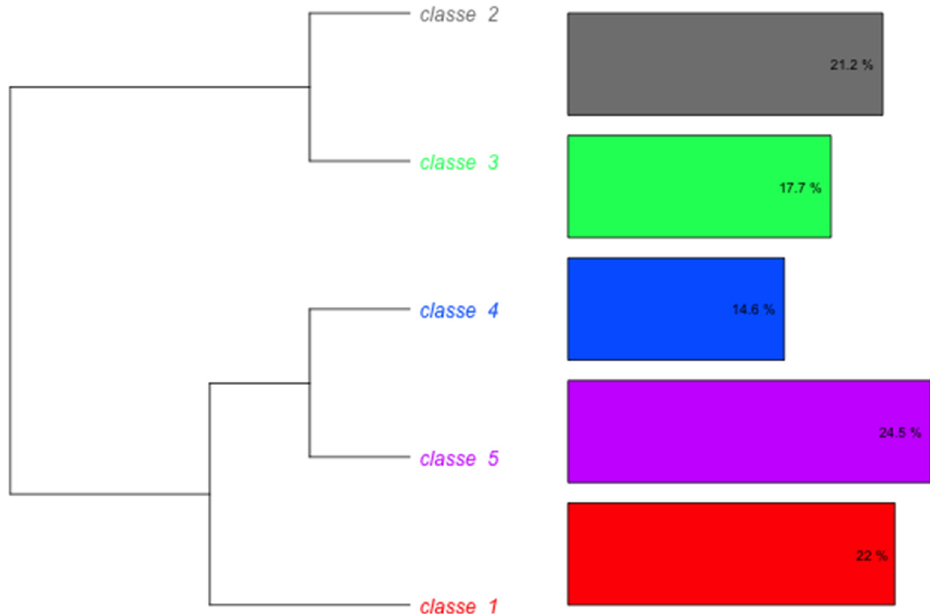
Figure 1. Dendrogram—parental corpus.